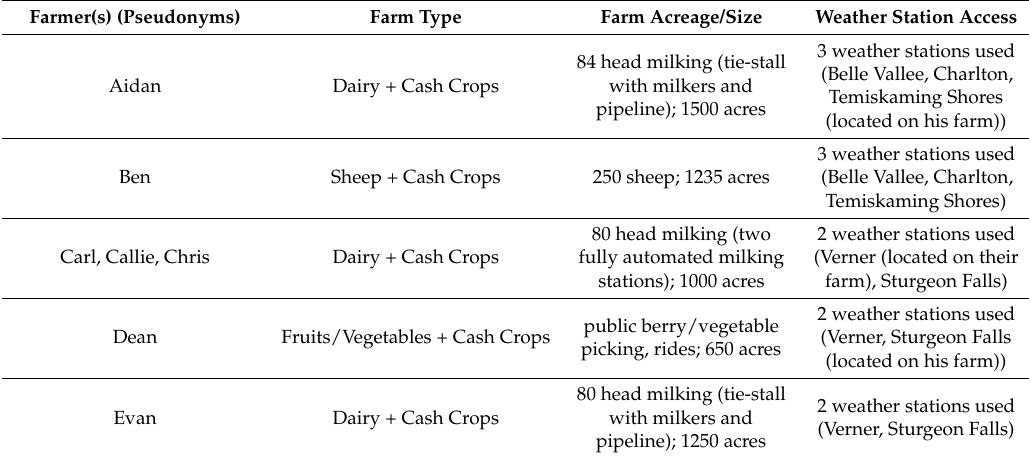
Table 1. Participating farm